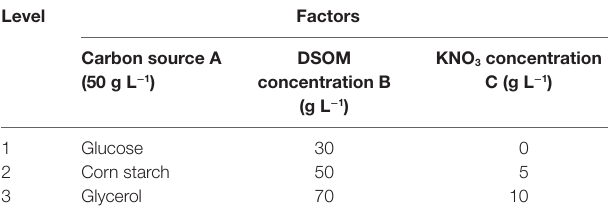
TaBle 2 | Levels and factors affecting EPA production.